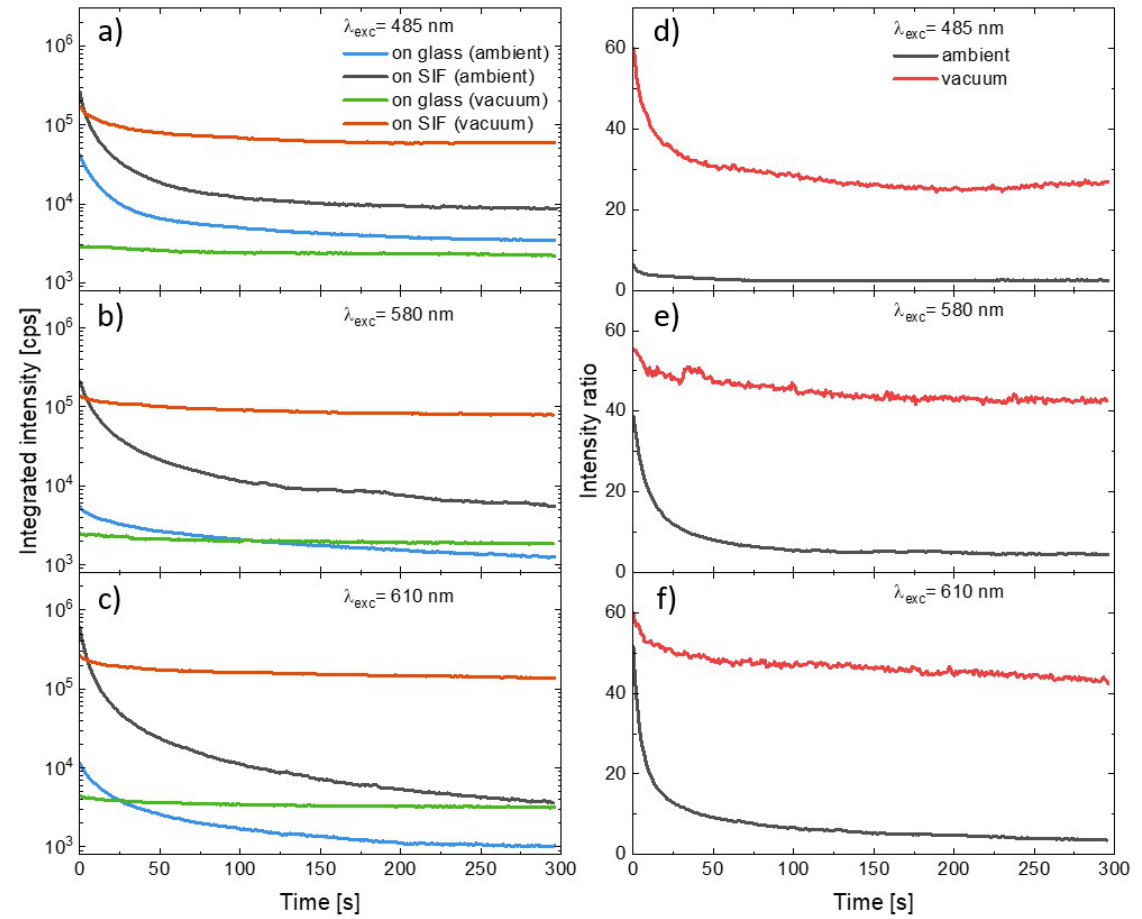
Figure 4. Temporal changes in the integrated intensity of the consecutive PSI–LHCI emission spectra measured for the excitation under 485 nm ( a ), 580 nm ( b ), and 610 nm ( c ). The PSI–LHCI layer was prepared on the glass (measured in ambient conditions, blue line, and in the vacuum, green line), as well as on the SIF (measured in ambient conditions, black line, and in the vacuum, red line). Corresponding temporal changes in the intensity ratio between samples prepared on the SIF and prepared on the glass are shown in the panels ( d – f ) (black and red lines for the measurements carried out in the ambient and vacuum conditions,